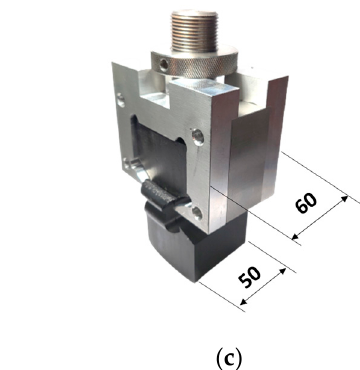
( d ) Figure 6. Results of 110 SDR 9 (Type A specimens) pipe BF joint (unit: mm): ( a ) load–displacement curves; ( b ) TWT_5 mm; ( c ) TWT_10 mm; ( d ) WT_5 mm fusion zone notch radius.